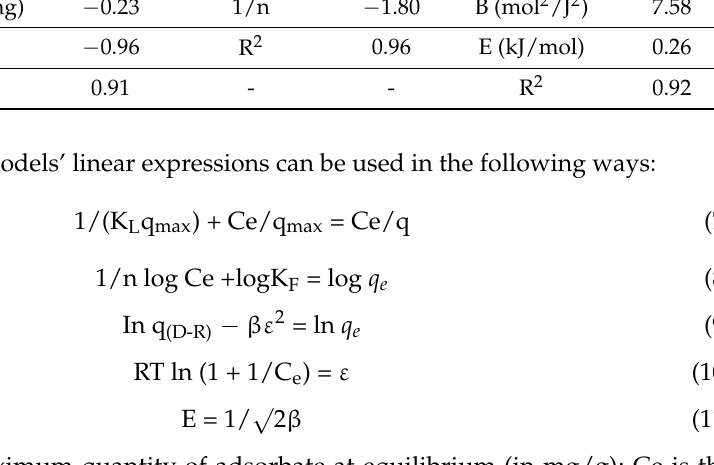
Table 2. Comparison of the coefficients of isotherm for PTZS adsorption onto GO-date Seeds.